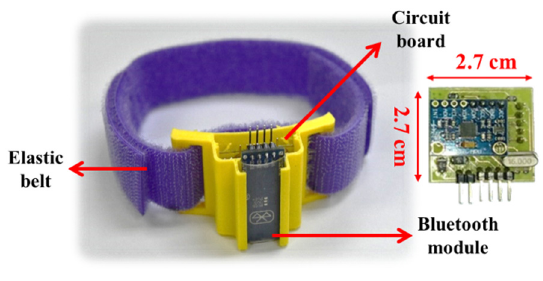
Figure 2. Structure of the proposed system.